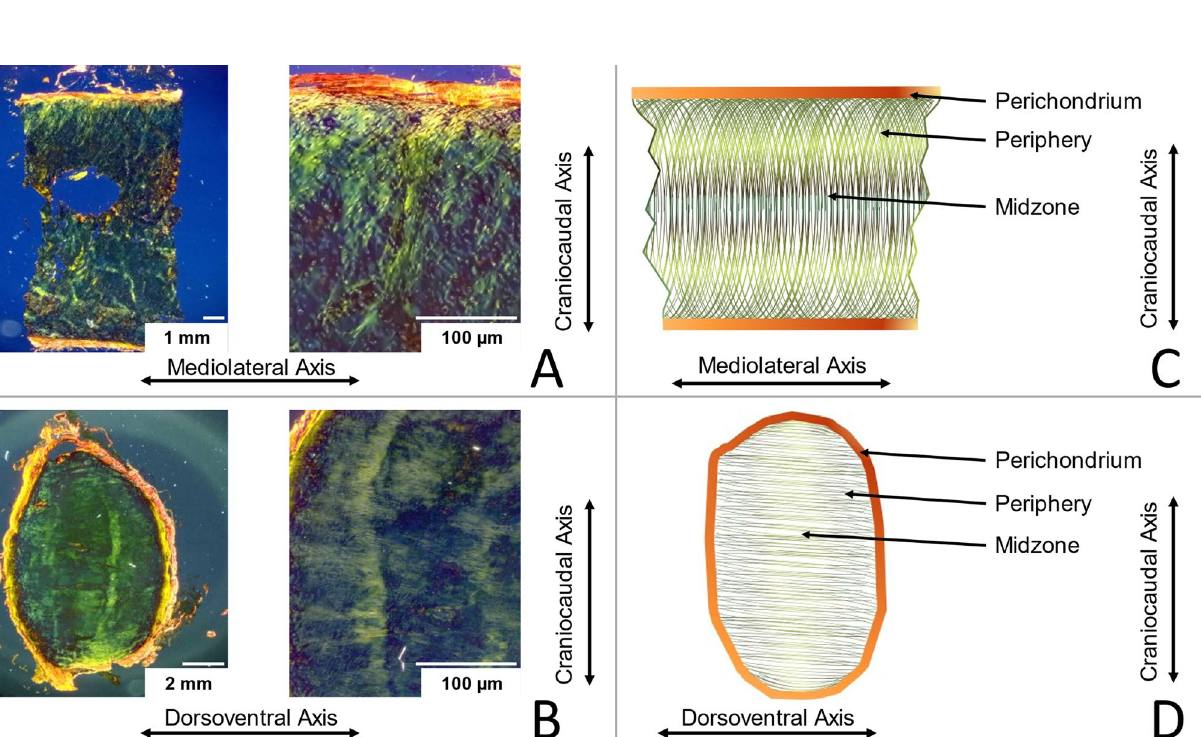
Figure 7. Costal cartilage samples stained with picrosirius red and examined with polarized light: ( A ) frontal plane, ( B ) sagittal plane. Schematic of the collagen fiber orientation ( C ) in frontal and ( D ) sagittal